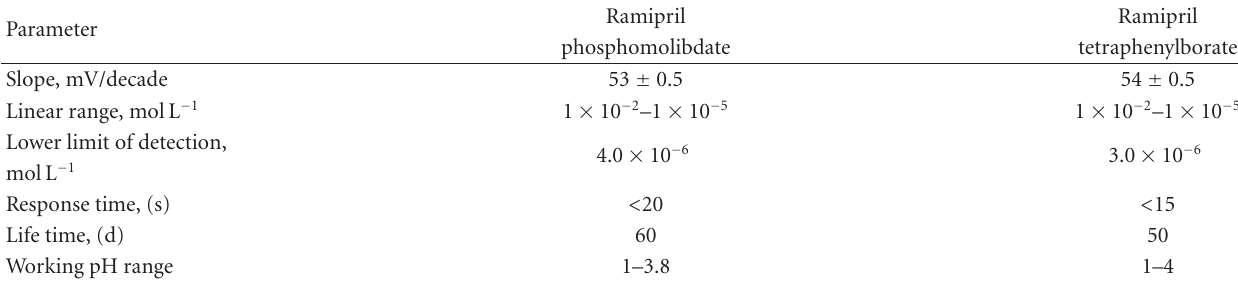
Table 1: Response characteristics of ramipril membrane-based selective